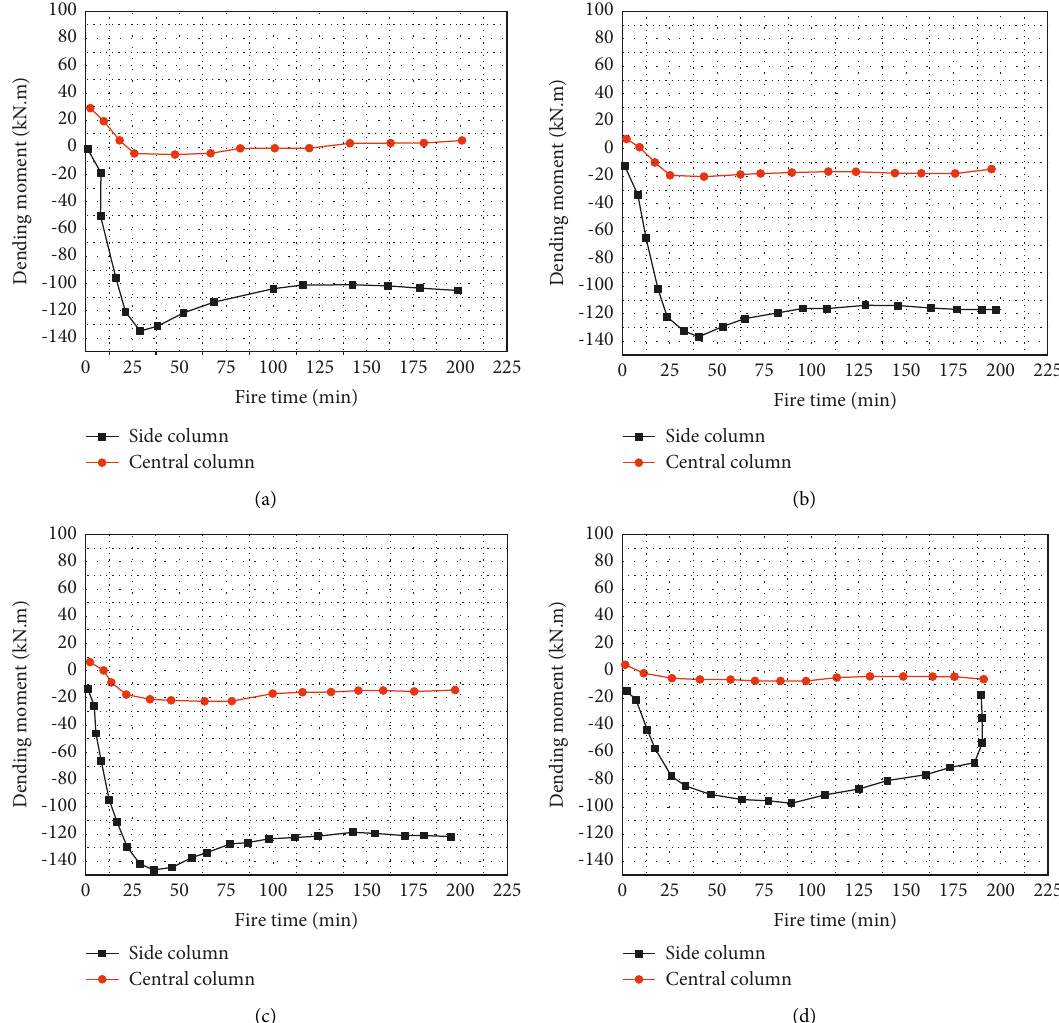
Figure 4: Variation of bending moment at the bottom of the reinforced column under different axial compression ratios. (a) Axial compression ratio n � 0.4; (b) axial compression ratio n � 0.6; (c) axial compression ratio n � 0.8; (d) axial compression ratio n �